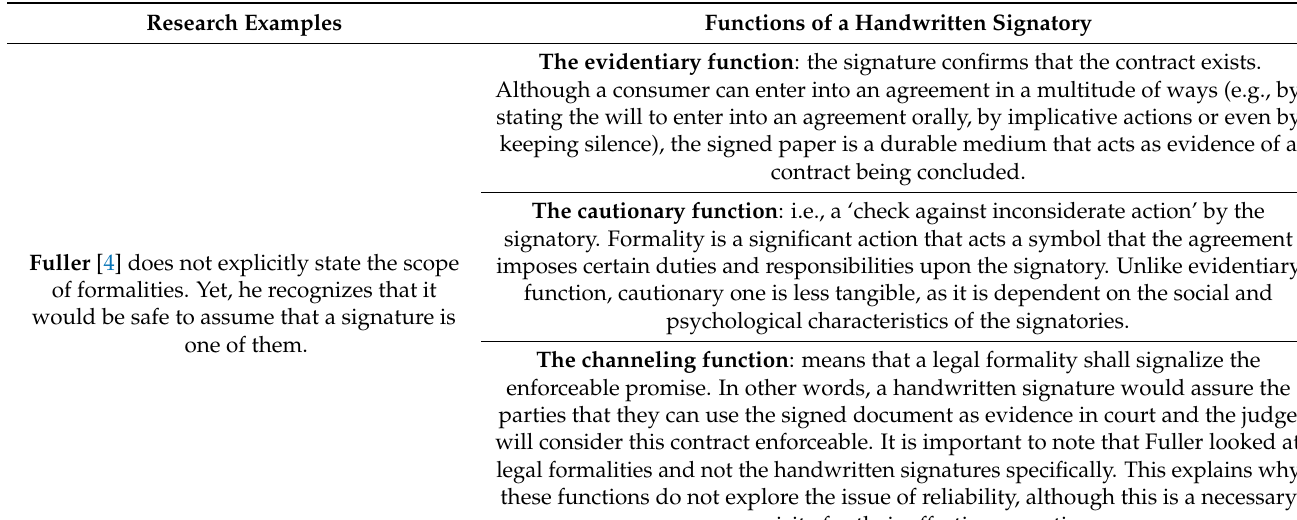
Table 1. Functional approach to defining handwritten